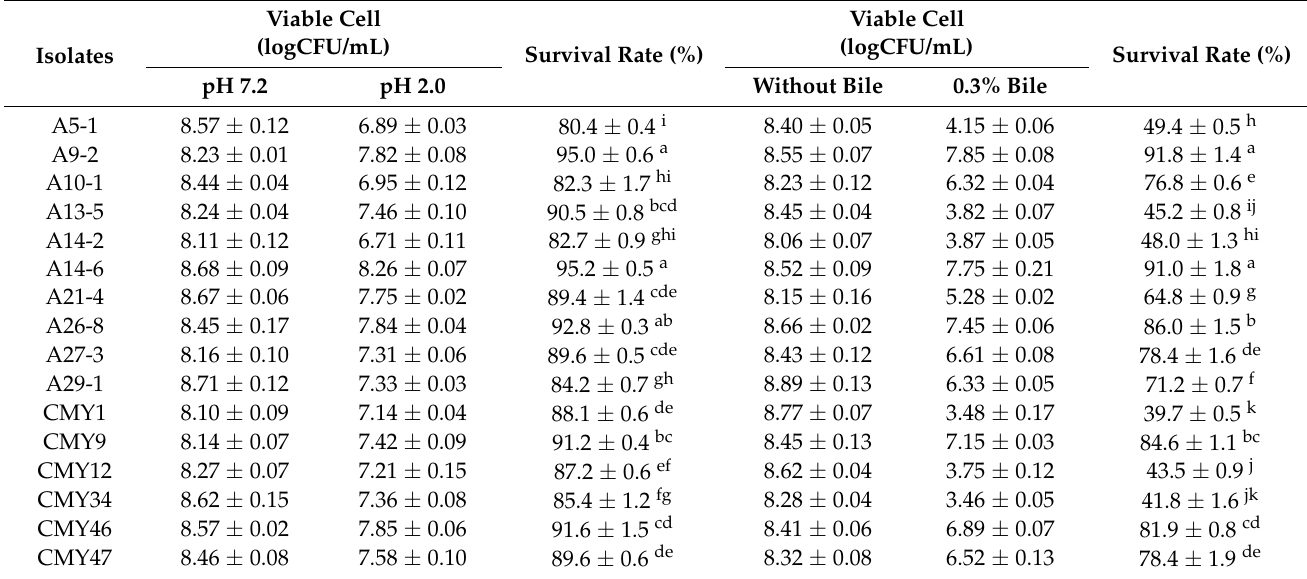
Table 1. Viability and survival percentages of sixteen LAB isolates after being incubated at pH 2.0 and 0.3% ( w / v ) bile salt at 37 ◦ C for 3